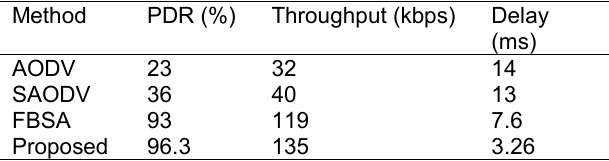
Figure 8 . Comparative analysis on throughput Analysis on delay